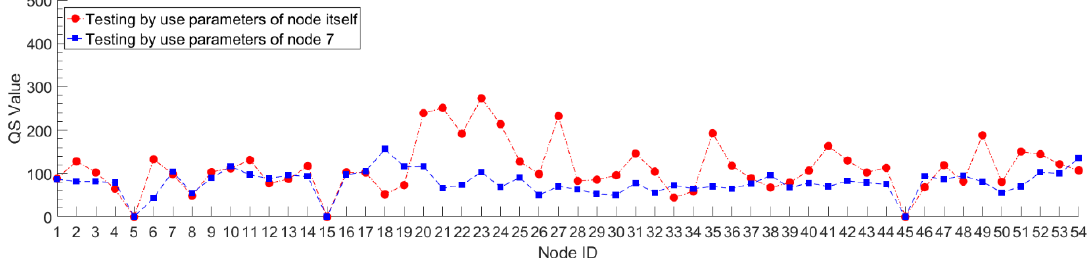
Figure 10. The QS value of each node on testing with different model parameters.